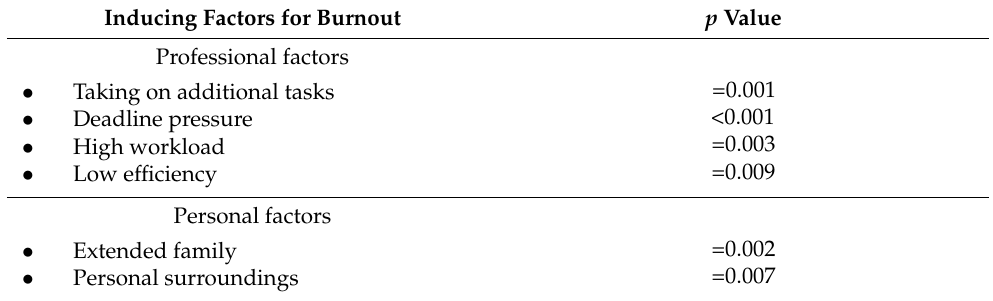
Table 8. Inducing factors for burnout.